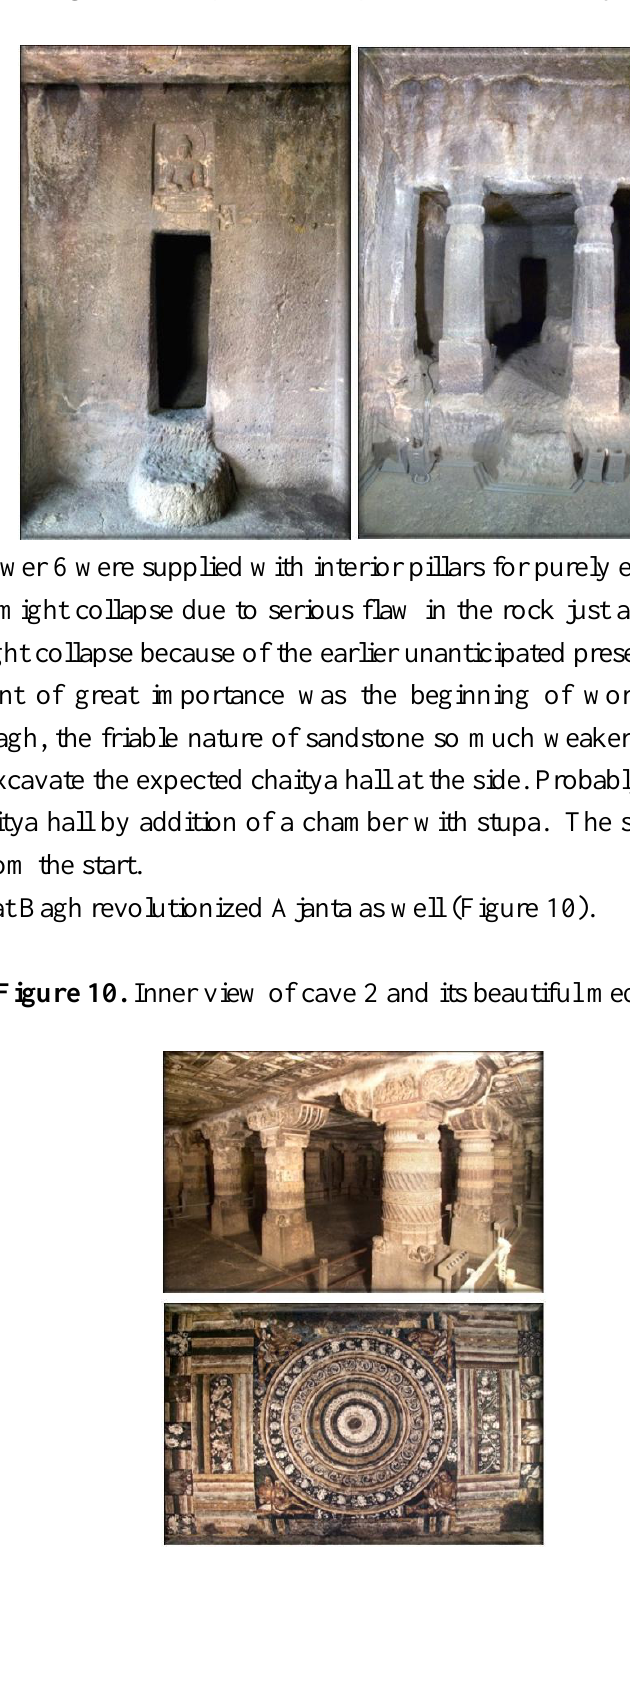
Figure 9. Simple and complex outer cells at Ajanta.